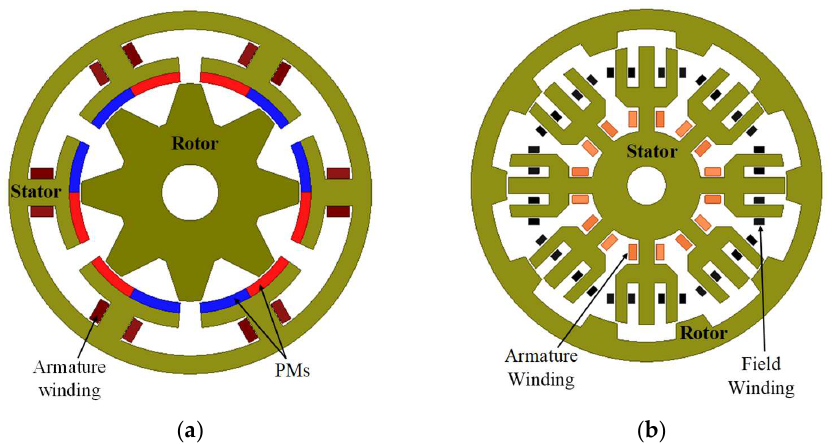
Figure 10. FRM architecture: ( a ) 6/8-pole 3-phase PM-FRM and ( b ) 8/10-pole 4-phase DC-FRM.